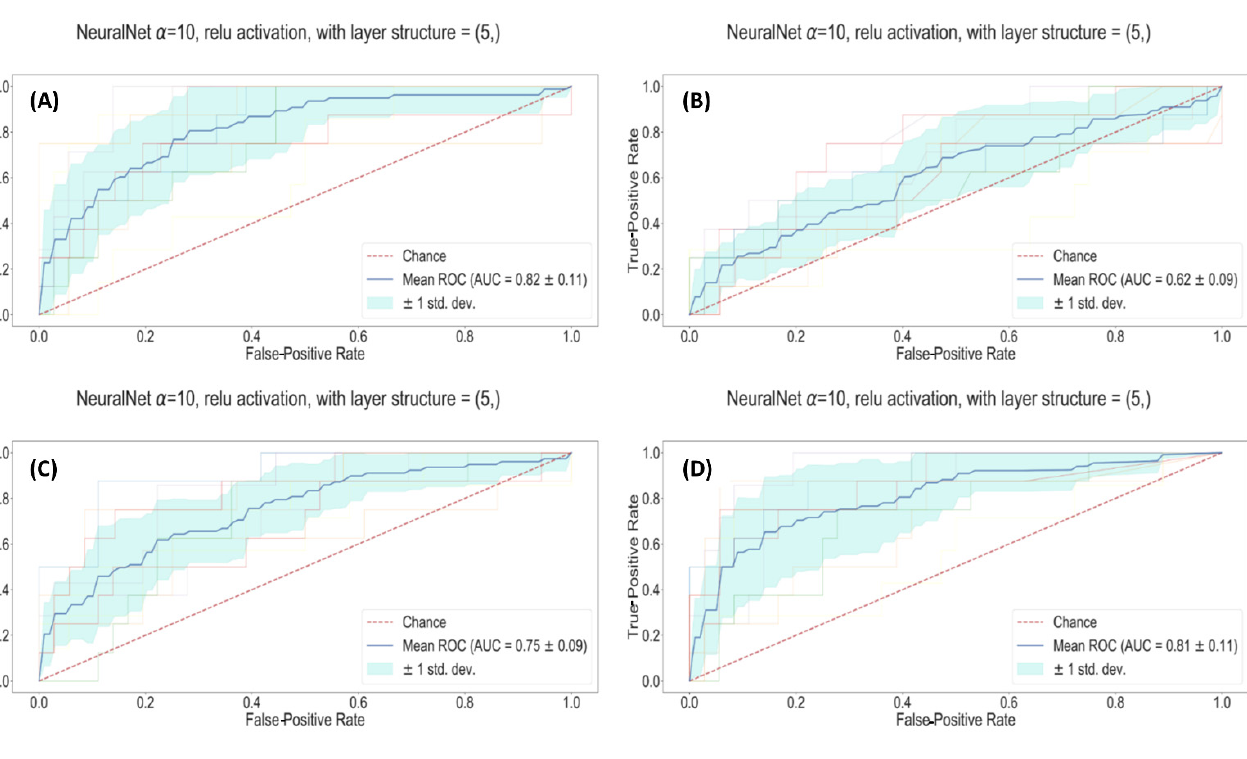
Figure 3. Performance of the FcNN classifier on different input features: ( A ) Clinical, ( B ) Radiological, ( C ) Radiomic, and ( D ) All available features.